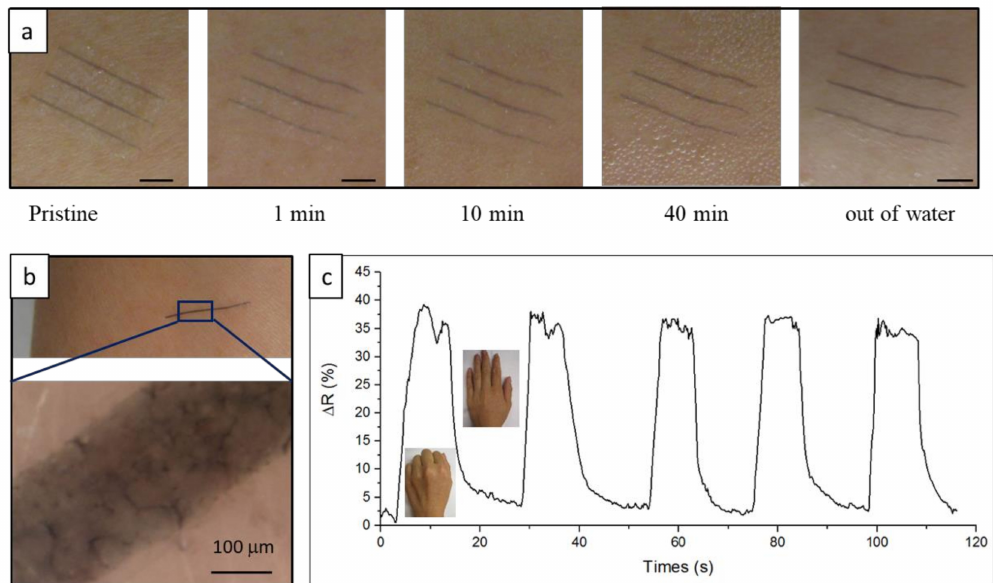
Figure 5. ( a ) Sequential images of transiency of all-polymer electrode on human forearm skin; scale bars present 10 mm. ( b ) Image of substrate-less electrode (after substrate was completely dissolved) on forearm skin taken with CCD camera and digital microscope. ( c ) Resistance fluctuation of pure electrode mounted on opisthenar to monitor hand